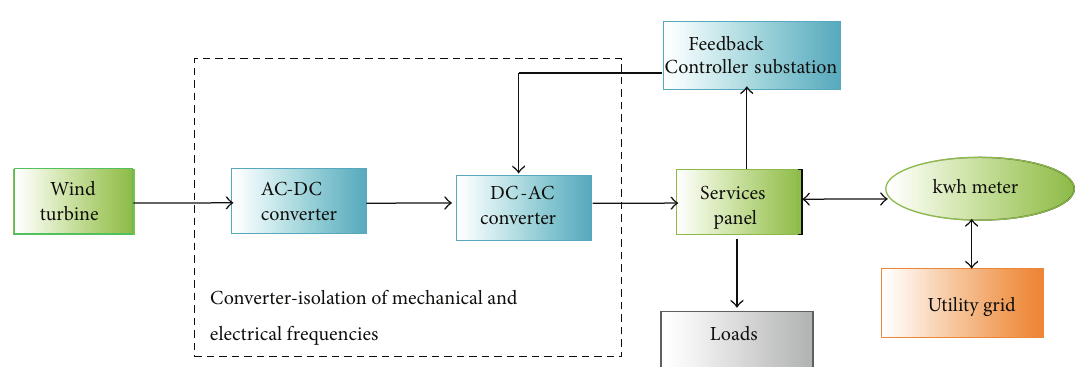
Figure 8: PV-based solar energy integration [92].